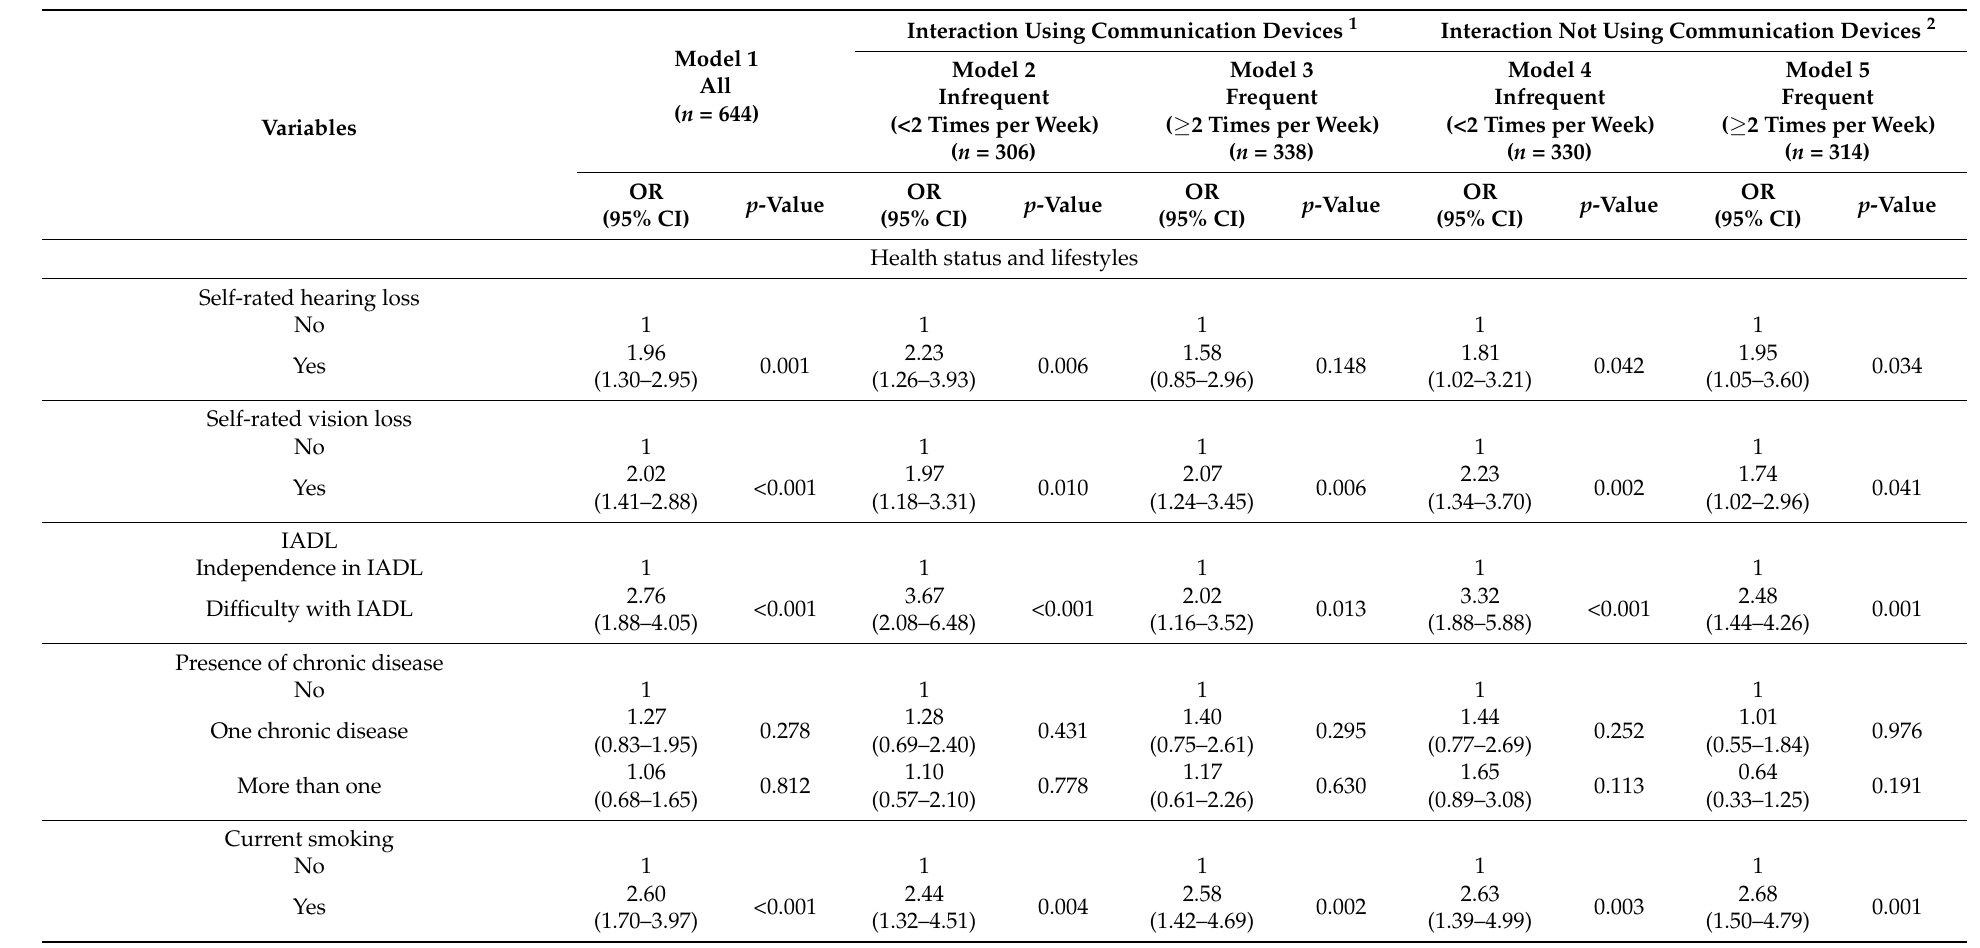
Table 3. Multivariable ordinal logistic regression analyses of the associations between hearing loss and cognitive